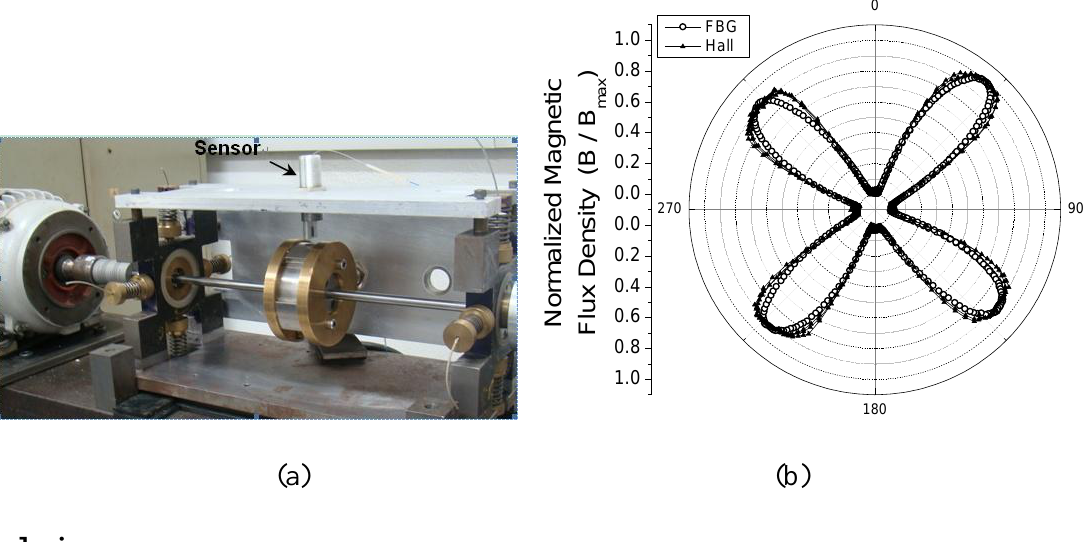
Figure 8. (a) Experimental setup; (b) Synchronous electrical and optical measurement of magnetic field from each pole swept passing the